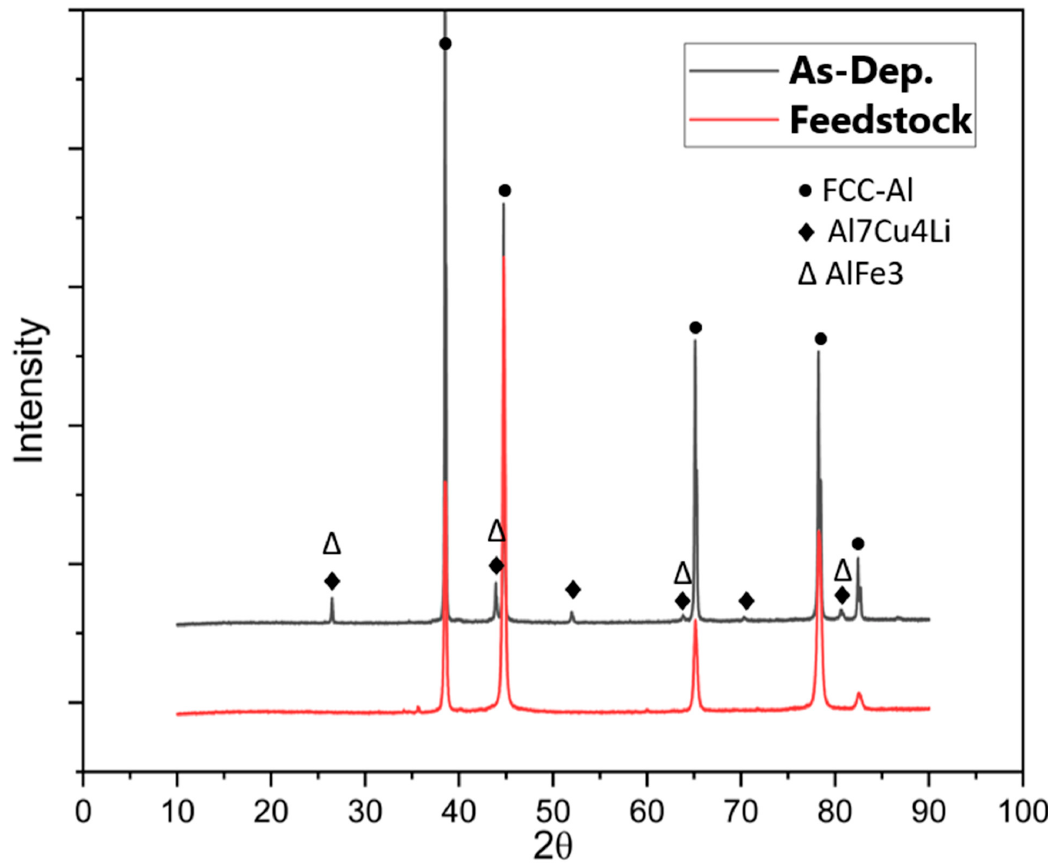
Figure 10. XRD patterns of the Al2050 feedstock used for AFSD processing and the as-deposited Al2050 part.